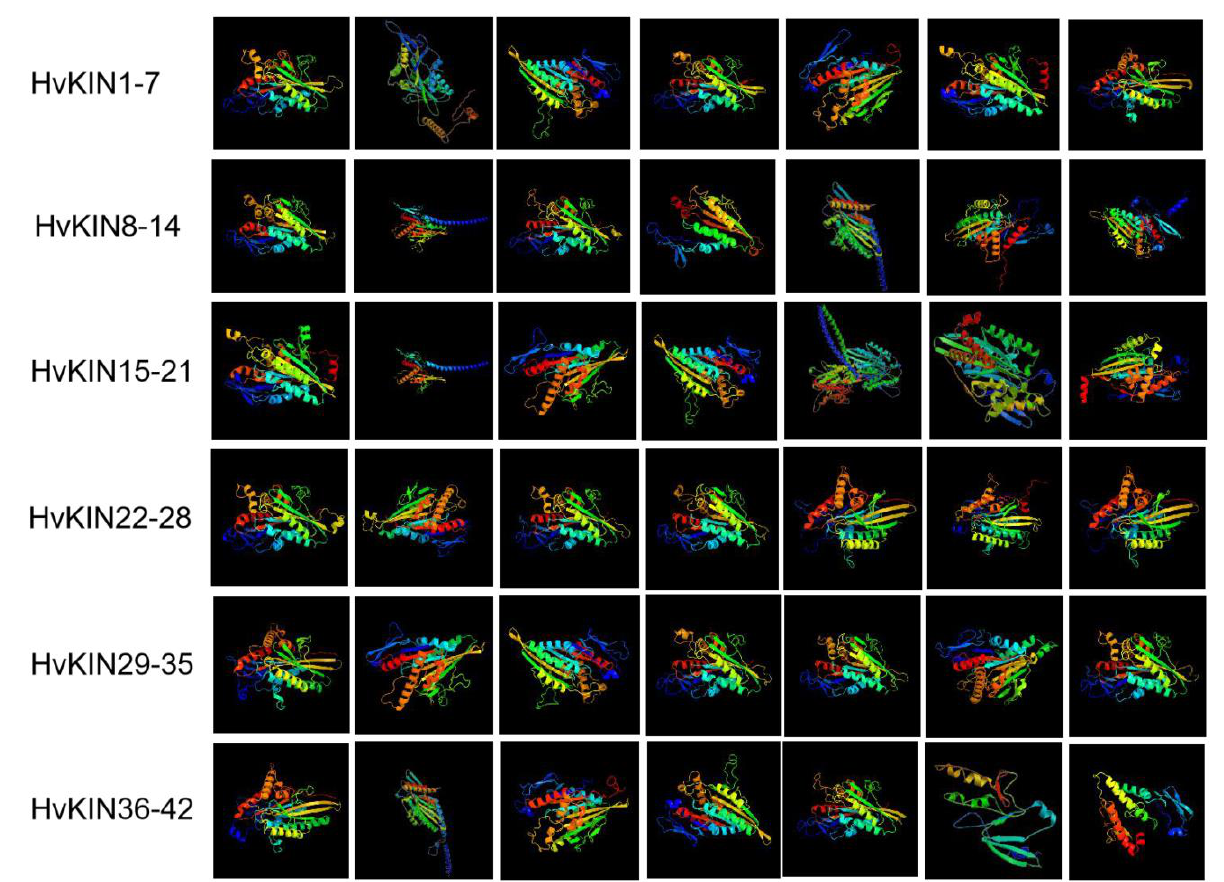
Figure 7. Structure of the HvKINs gene 3D protein.